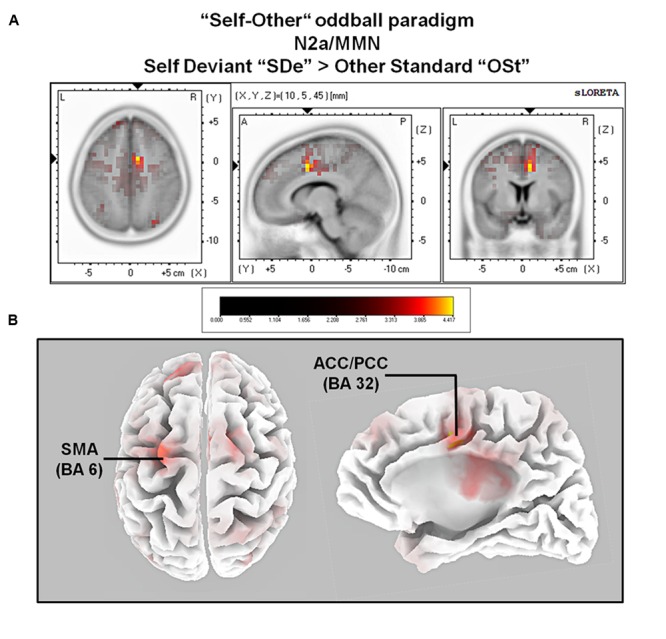
Results of the sLORETA source localization analysis (contrast: “SDe” > “OSt”) in the averaged time window of the N2a/MMN component (180–219 ms). Images have been obtained after SnPM and co-registration to the stereotaxic Talairach space based on the Co-Planar Stereotaxic Atlas of the Human Brain (Talairach and Tournoux, 1988) and the probabilistic MNI-152 template (Mazziotta et al., 2001). Activated voxels are indicated by yellowish and reddish colors [after correction for multiple comparisons (p < 0.01 and p < 0.05, respectively)]. (A) The peak of highest cortical activity was found in parts of the right ACC/PCC (BA 32) on the right medial surface of the brain. (B) A top view on the brain (left panel) shows highest cortical activity in the left supplementary motor area (SMA; BA 6). A lateral view on the right medial surface of the brain (right panel) shows cortical activations in the right ACC/PPC (BA 32), rendered on the Colin27 template (Holmes et al., 1998). L, left; R, right; A, anterior; P, posterior; MNI, Montreal Neurological Institute; X, Y, Z, corresponding MNI coordinates; BA, Brodmann area; SMA, supplementary motor area; ACC, anterior cingulate cortex; PCC, posterior cingulate cortex.